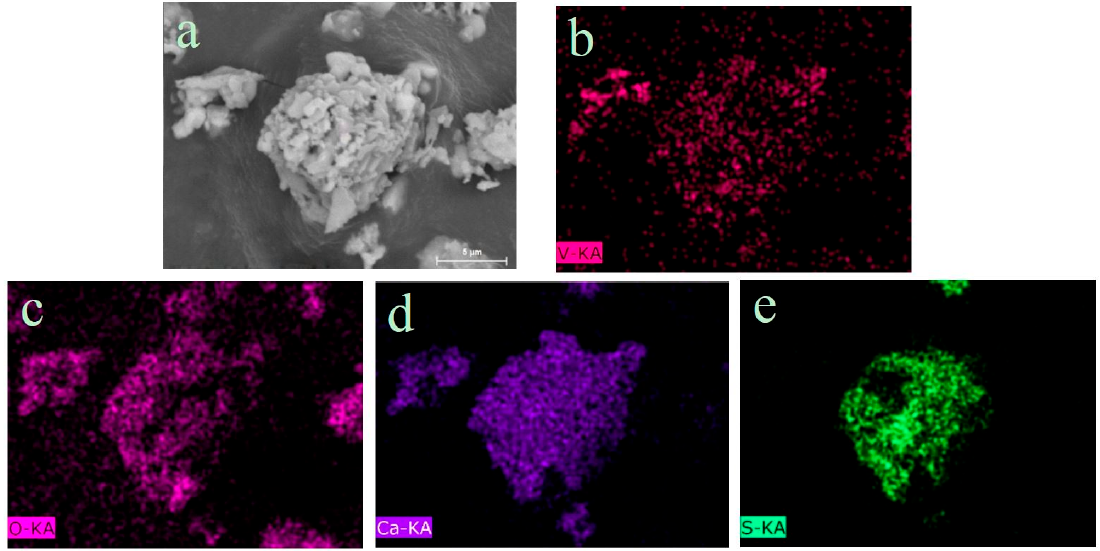
Figure 8. ( a ) BEI of raw stone coal; EDS elemental distribution: ( b ) V; ( c ) O; ( d ) Ca; ( e ) S.